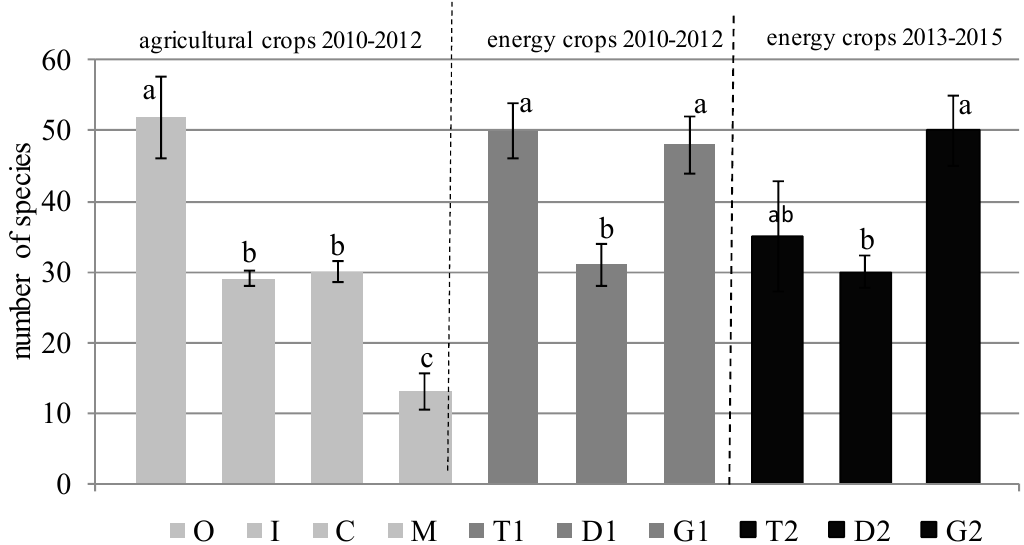
Figure 4. Total number of weed species in different farming systems and in groups of plants cultivated for energy purposes. Values are the three-year mean ± SD ( n = 3). Values with the same letter are not significantly different according to the nonparametric Kruskal ‒ Wallis test ( p ≤ 0.05). Explanations of symbols: O—Organic, I—Integrated, C—Conventional, M—Monoculture of winter wheat, T—Trees and bushes, D—Dicotyledonous, G—Grasses; 1—2010–2012, 2—2013–2015.